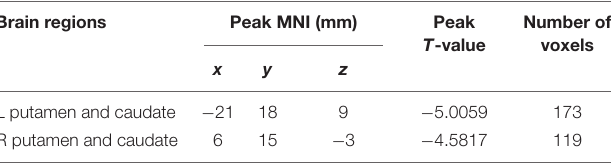
TABLE 3 | Significant difference between hemodialysis patients and healthy controls in functional connectivity between the bilateral caudate (used as seed area) and the rest of the whole brain.